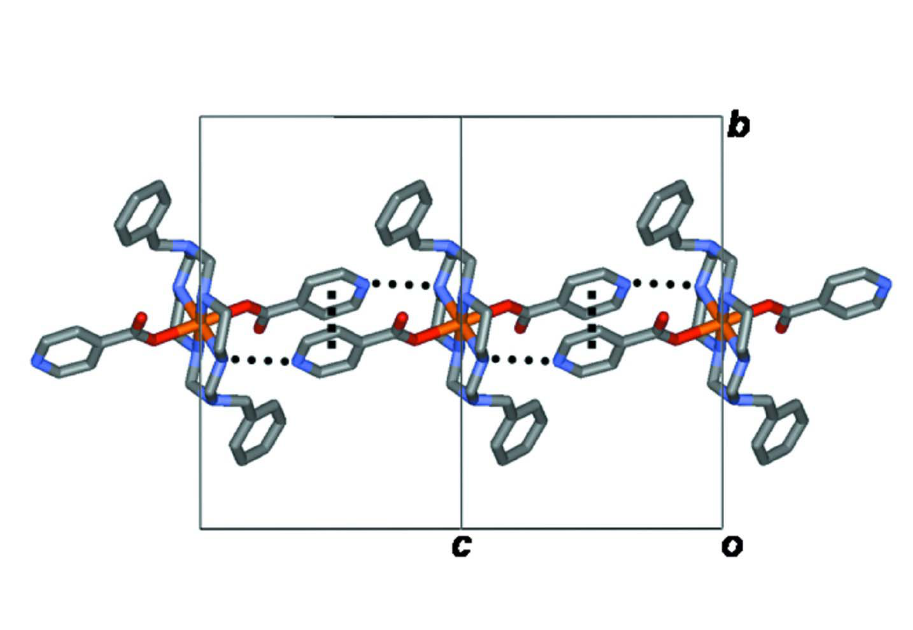
Figure 2 Perspective view of the title compound showing a 1-D chain along the c axis by hydrogen bonding interactions (black circles) and offset face-to-face π - π interactions (black